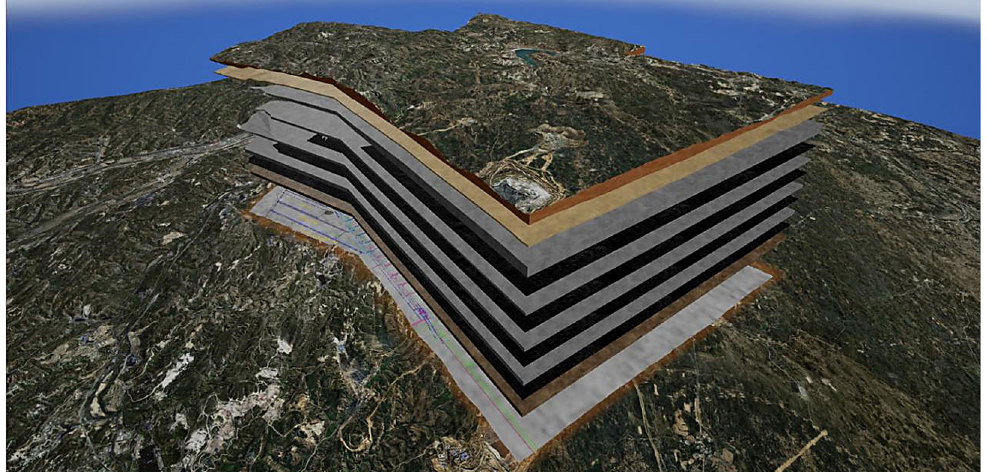
Fig. 3 3D geological model of the transparent